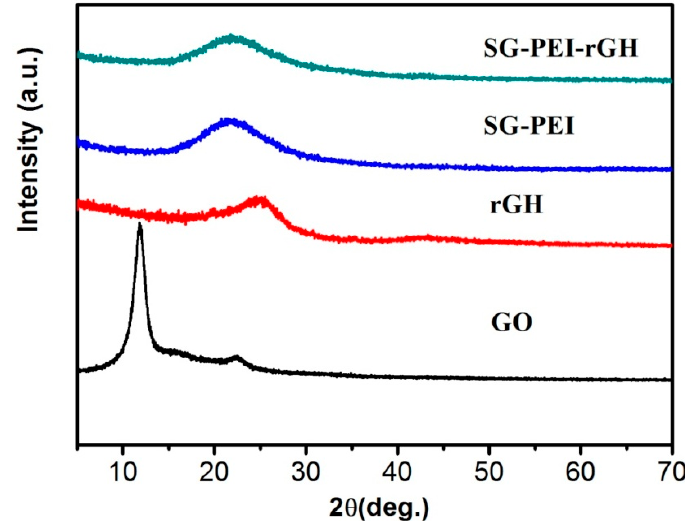
Figure 2. XRD patterns of GO, rGH, SG-PEI, and SG-PEI/rGH.